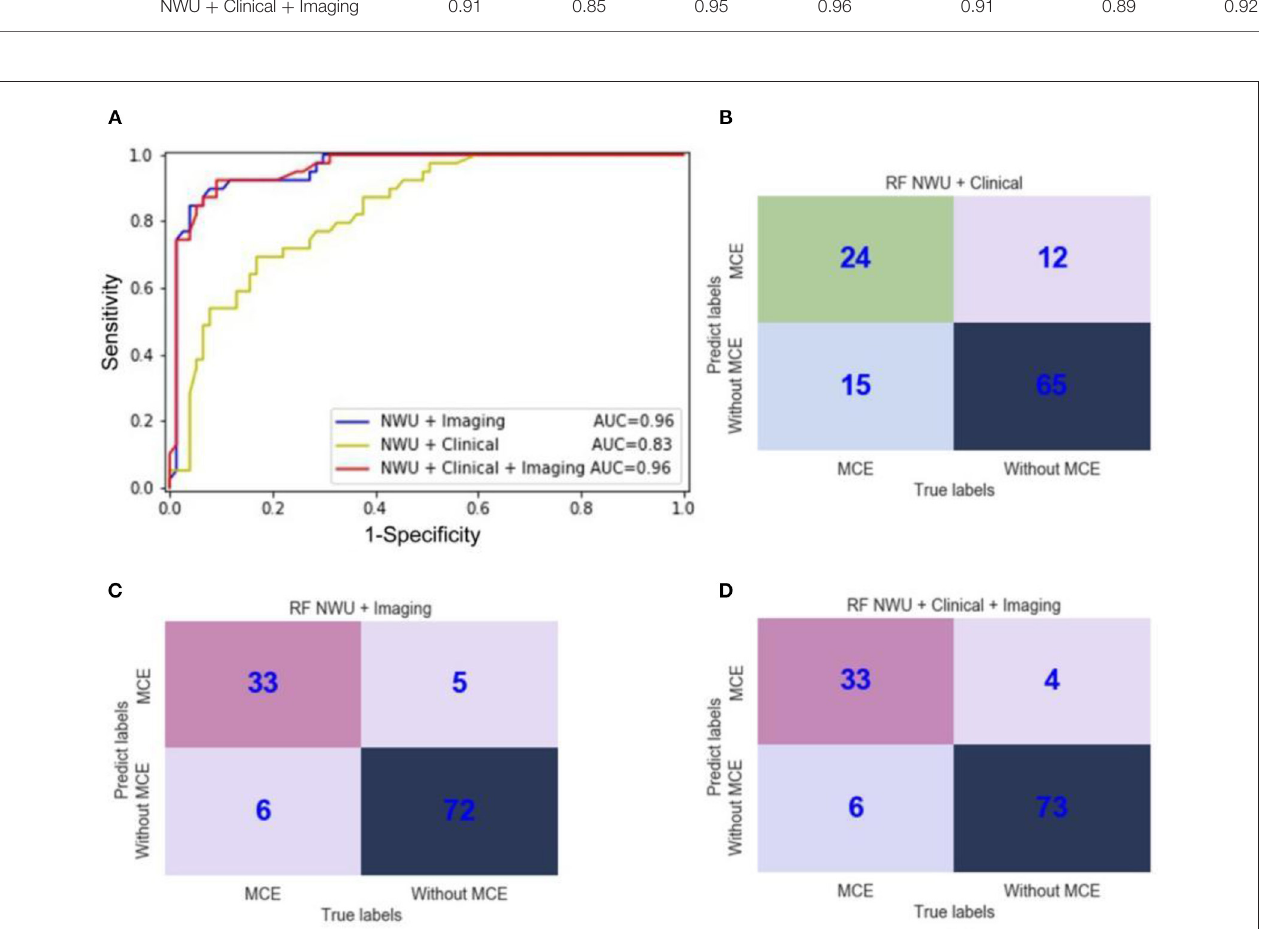
FIGURE 7 | ROC curves and confusion matrices of three random forest (RF) radiomics models for the prediction of malignant cerebral edema (MCE). (A) ROC curves of three RF radiomics models with different features; (B) The confusion matrix for a model with RF and features of “NWU + Clinical;” (C) The confusion matrix for a model with RF and features of “NWU + Imaging;” (D) The confusion matrix for a model with RF and features of “NWU + Clinical +